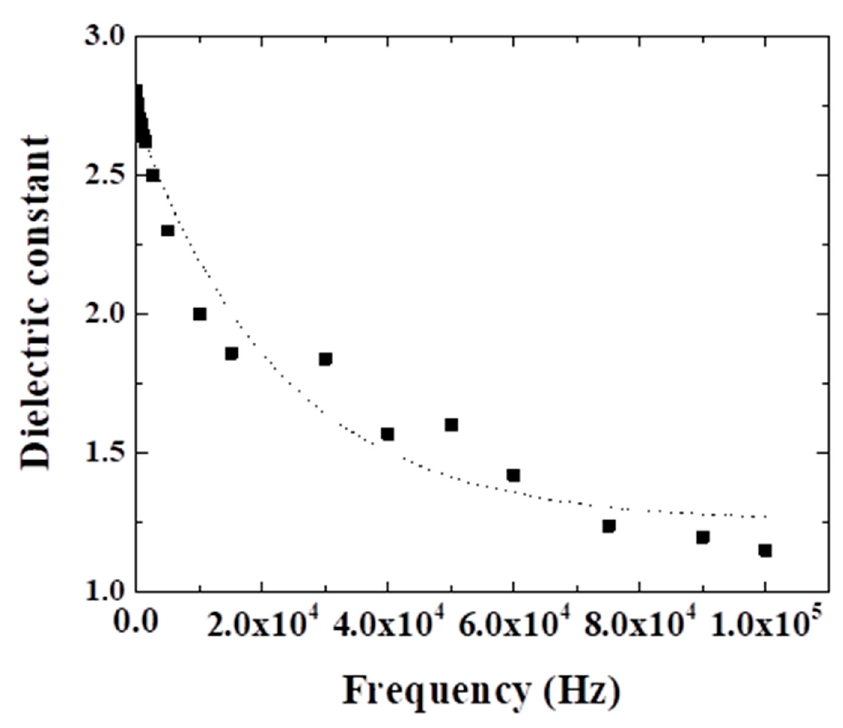
Figure 9. Dielectric constant versus frequency for a sample containing 3% wt. graphene.